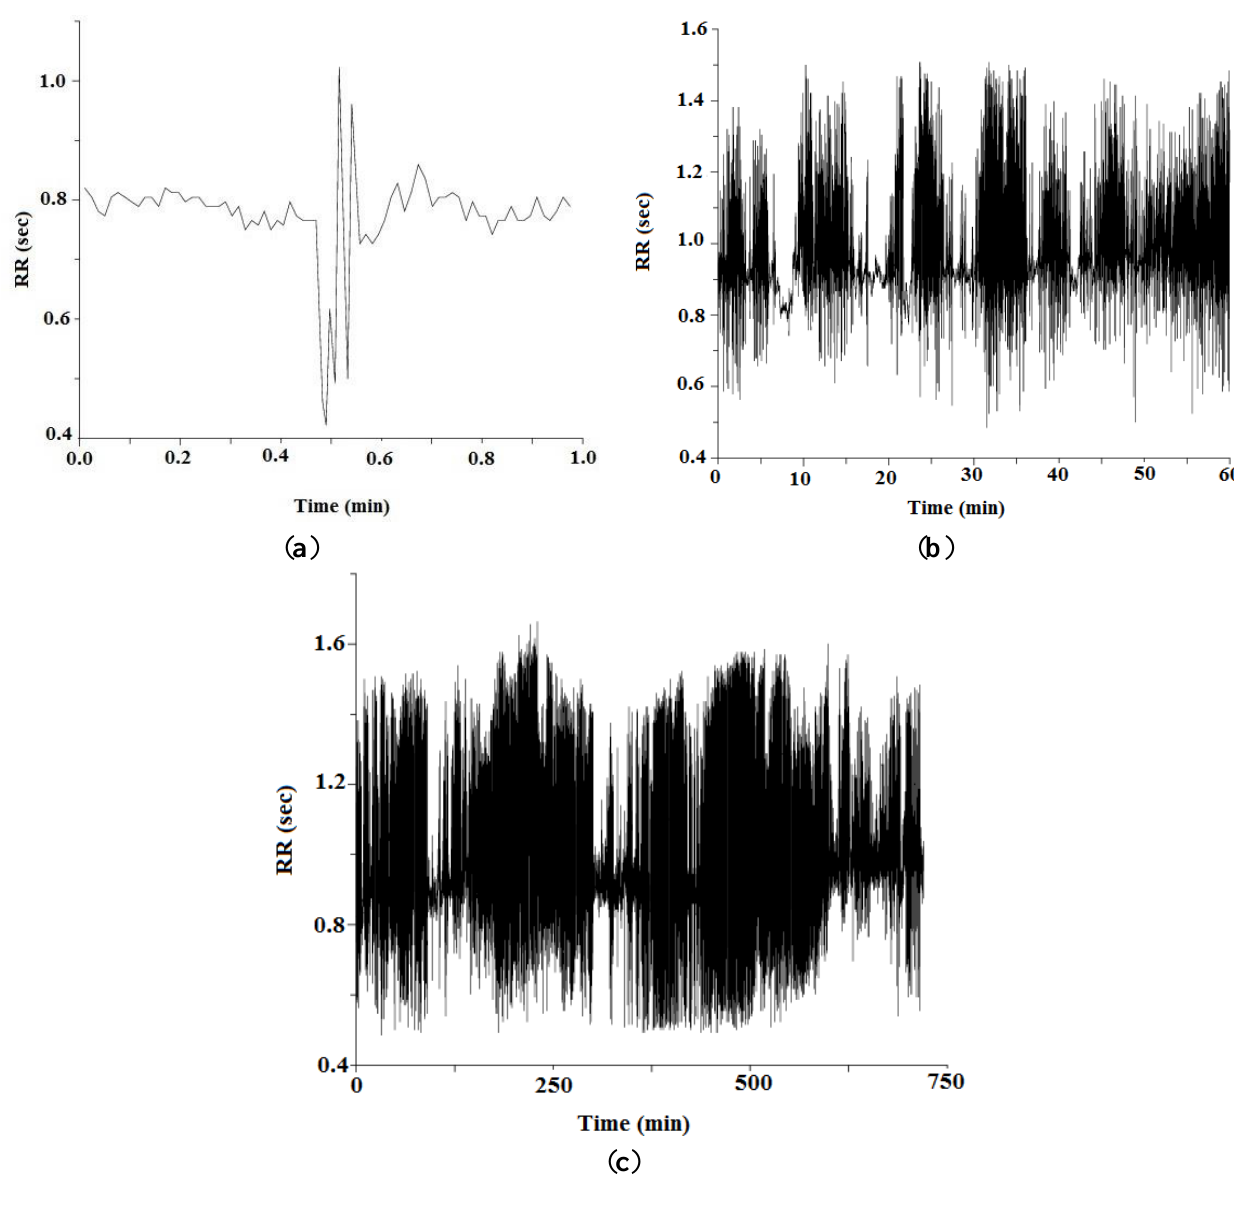
Figure 8. The inter-beat (RR) interval representation ( a ) RR-interval for 1 min; ( b ) RR-interval for 1 h; and ( c ) RR-interval for complete